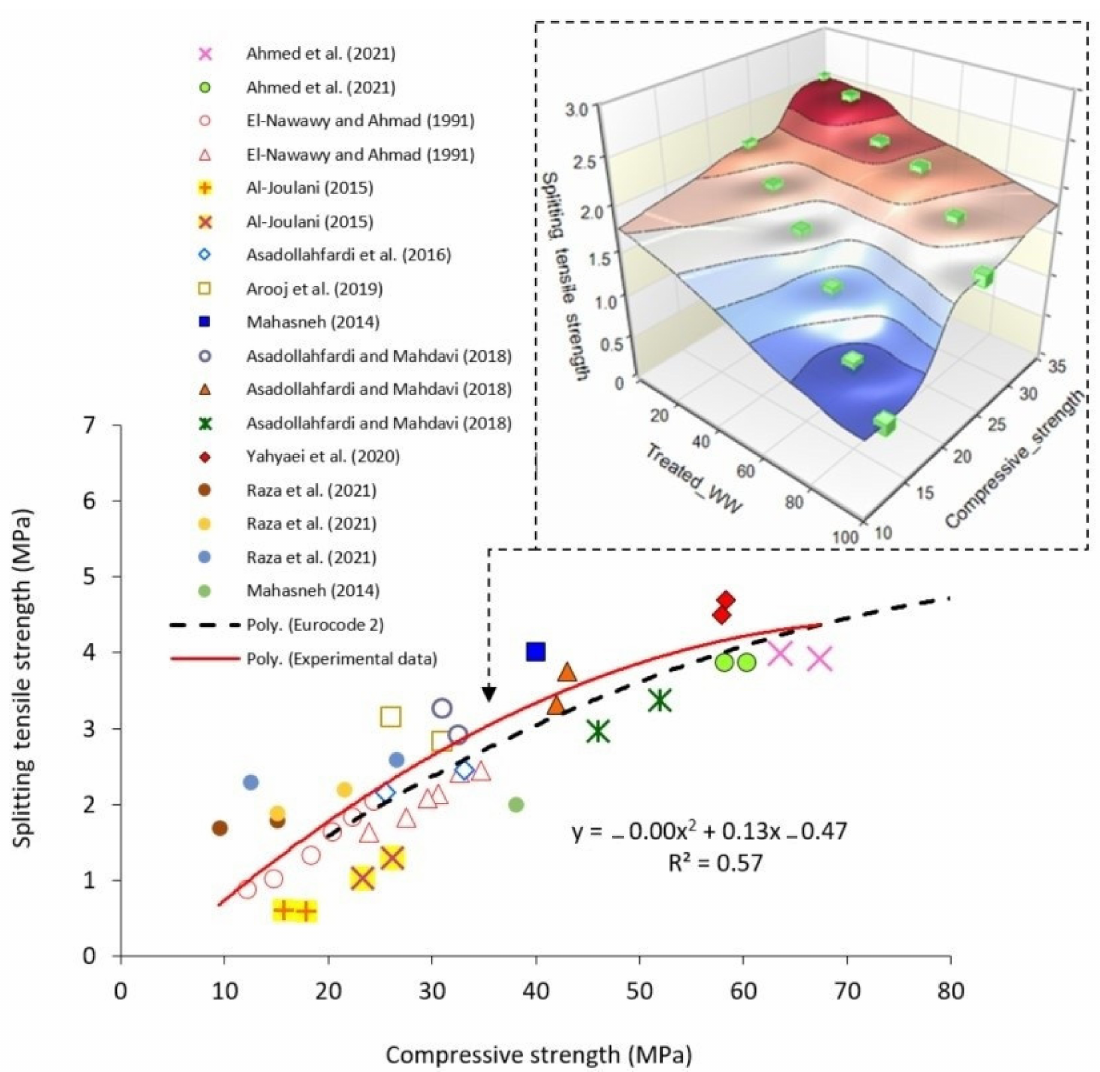
Figure 12. Relationship between compressive strength and splitting tensile